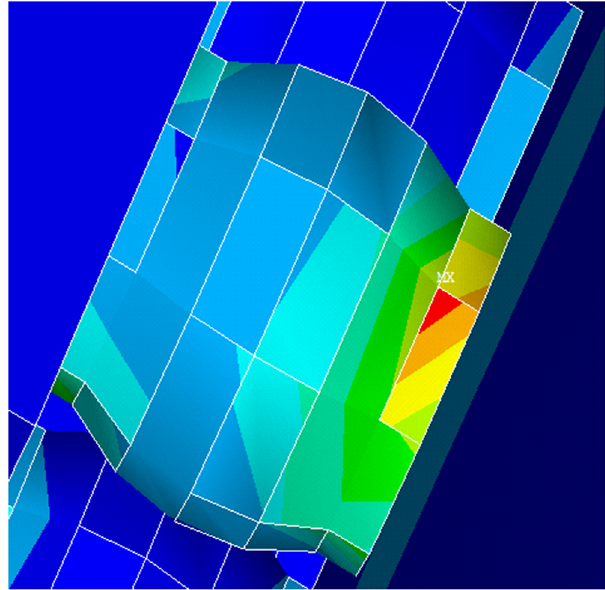
Fig. 14. Stress distribution on the corner solder ball.